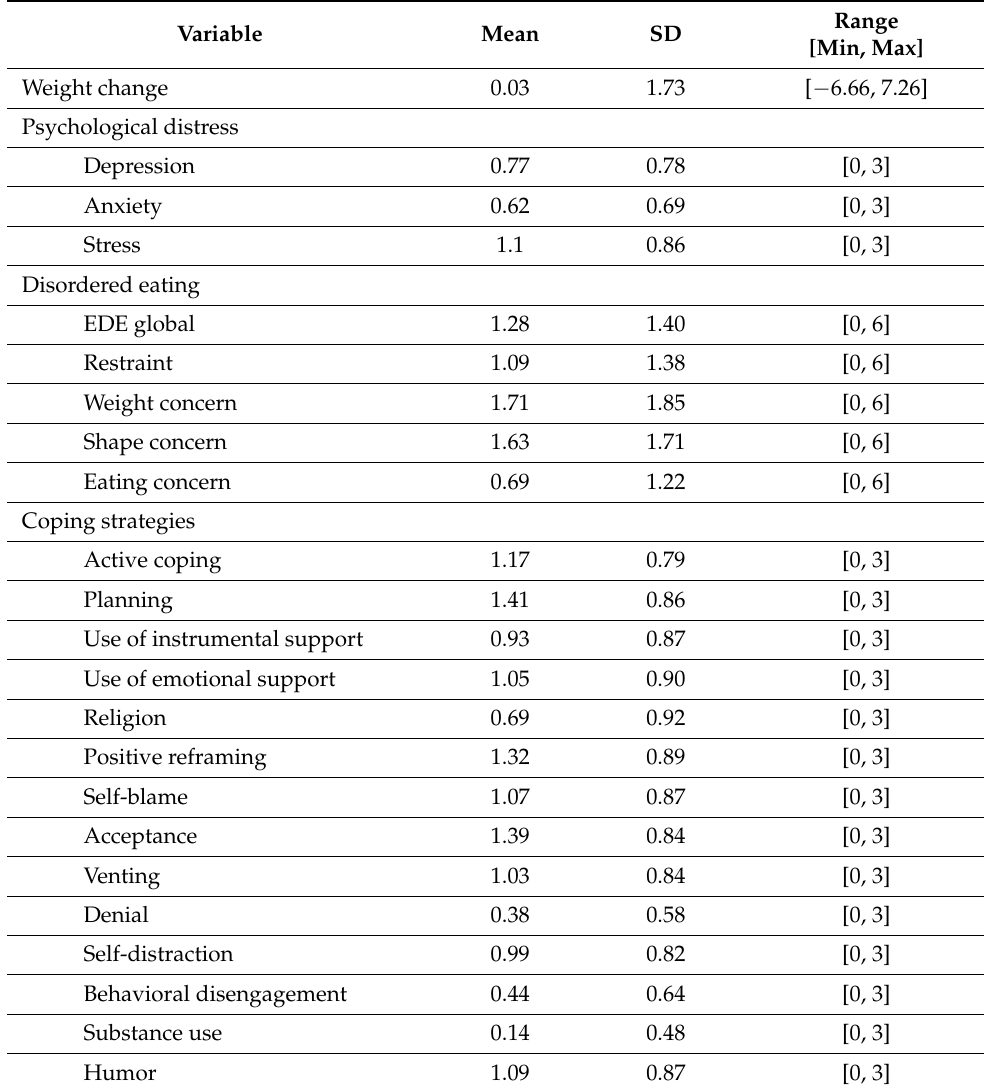
Table 1. Clinical characterization of the